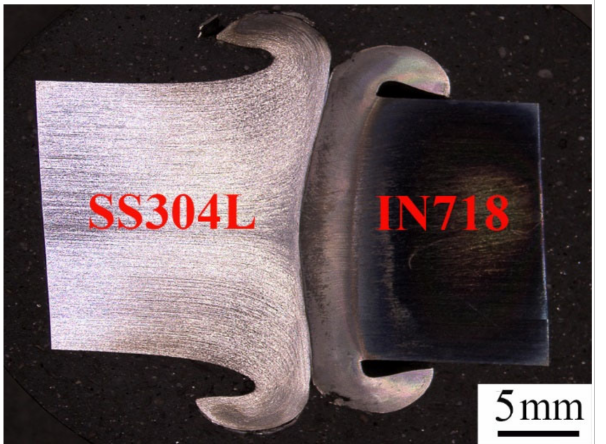
Figure 6. A visual view of SS304L/IN718 friction weld joint in the as-welded ( a ) ST, and ( b ) STA conditions.